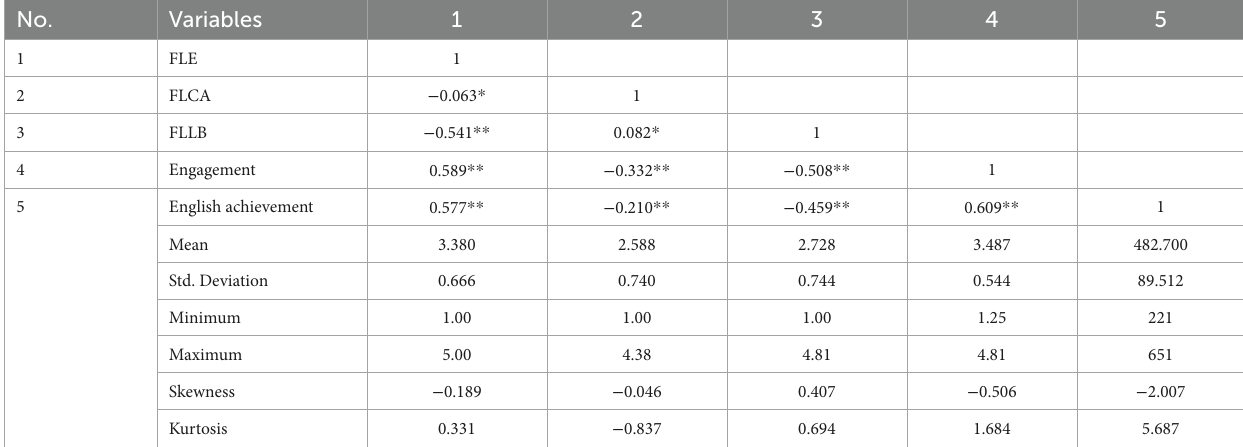
TABLE 2 Descriptive statistics and correlations.